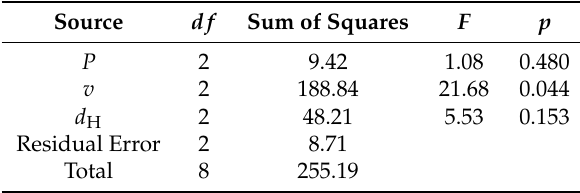
Table 8. Analysis of variance for S/N ratios of upskin surfaces, R 2 = 96.59%.